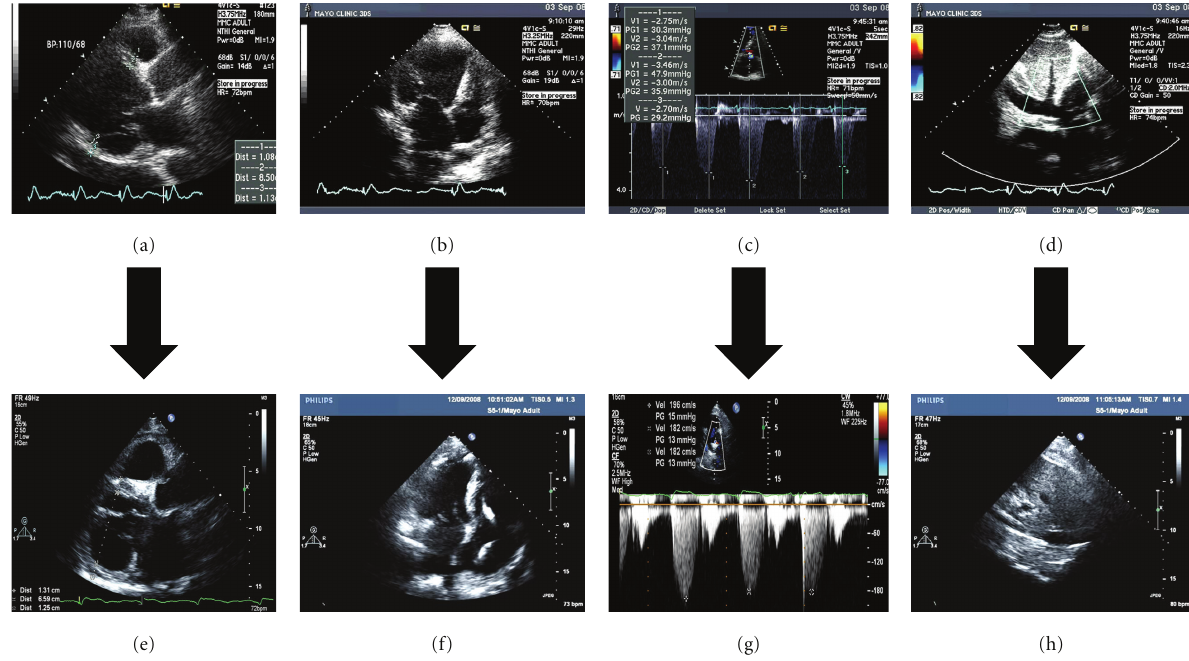
Figure 2: Interventricular dependency. Parasternal long axis view showing severely dilated LV (end-diastolic dimension 85mm). (b) Apical 4-chamber view showing interventricular, interatrial septa shifted to the right, and increased tenting and annular dimensions of mitral valve apparatus. (c) and (d) Systolic right ventricular and right atrial pressure is increased. The same patient two months after surgery. (e) End- diastolic diameter decreased, and septal and posterior walls have thickened. (f) Interventricular and interatrial septa are now shifted to the left. Mitral annulus and tenting area have decreased as well as functional mitral regurgitation. (g) and (h) Systolic right ventricular and right atrial pressures have decreased